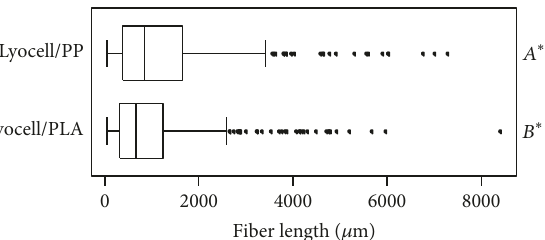
Figure 7: Box-Whisker plots of fiber length distribution of fibers extracted from IM lyocell/PP and IM lyocell/PLA composites (results do not follow a normal distribution; different letters show significant